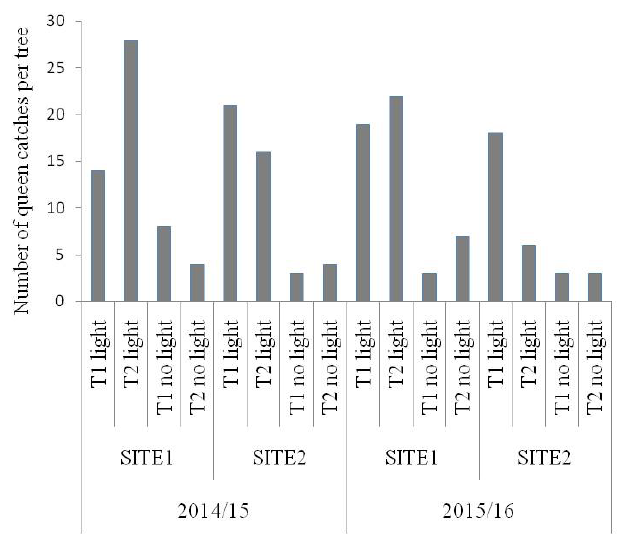
Fig 1 . Number of O. longinoda queen catches per tree from two sites in 2014/15 and 2015/16 at Naliendele Agricultural Research Institute, Mtwara, Tanzania. Where: T1 and T2 are tree number 1 and 2